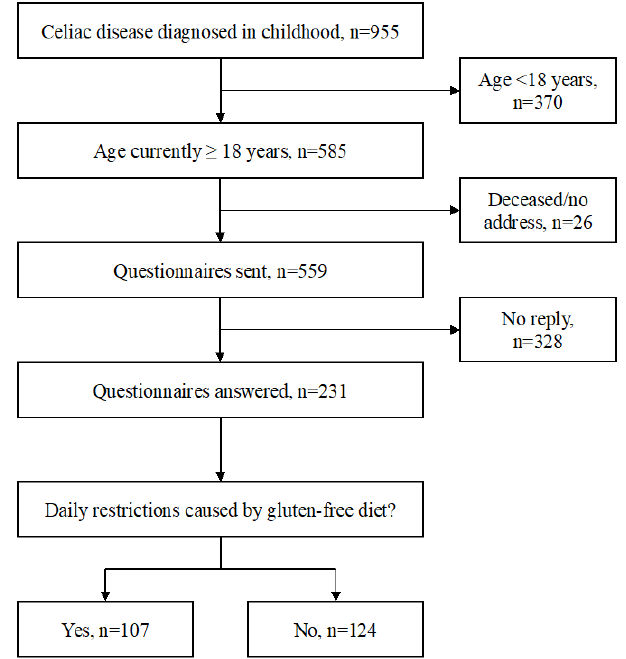
Figure 1. Flowchart of the data collection and study groups.